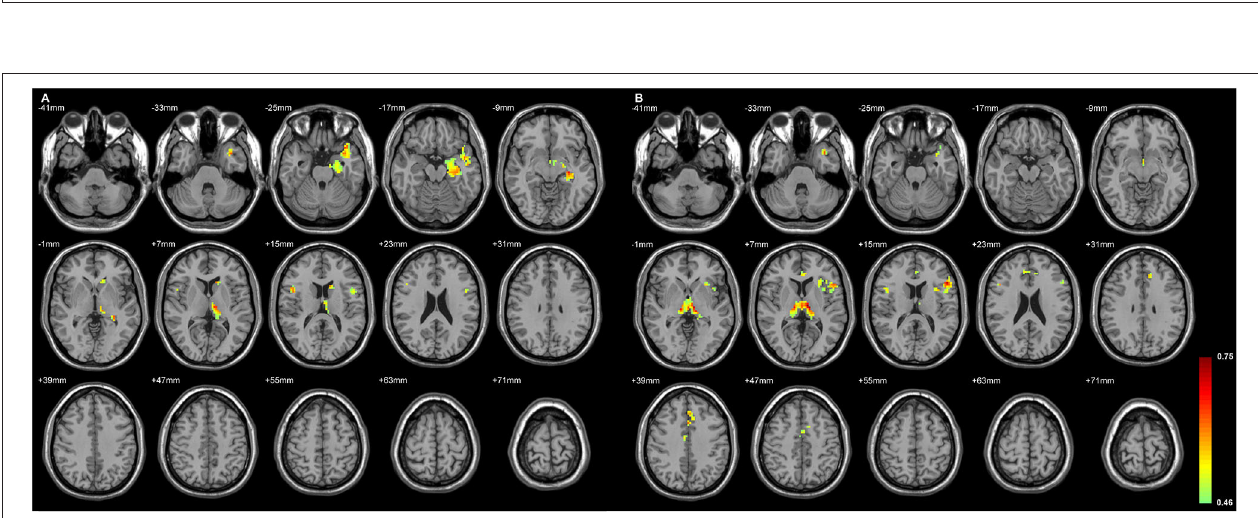
FIGURE 4 | The regions with their GMD related to the (A) left AV-LD-LP- CeM-CL-MV(Re) volume loss and the (B) right LD-MV(Re) volume loss in L-TLE. All depicted regions showed a positive relationship, and were mostly located in the left frontal and temporal lobes. GMD of the left inferior frontal gyrus was positively related to each side of thalamic subfield volume changes in L-TLE. Differences with a p < 0.01 were considered significant (with a threshold p < 0.01 and a minimum cluster size = 354 voxels, as determined by the AlphaSim